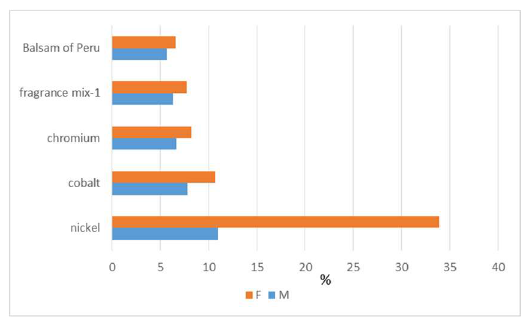
Figure 1. Percentages of sensitization to the top-five sensitizers in both genders. Figure 1 . Percentages of sensitization to the top-five sensitizers in both genders.